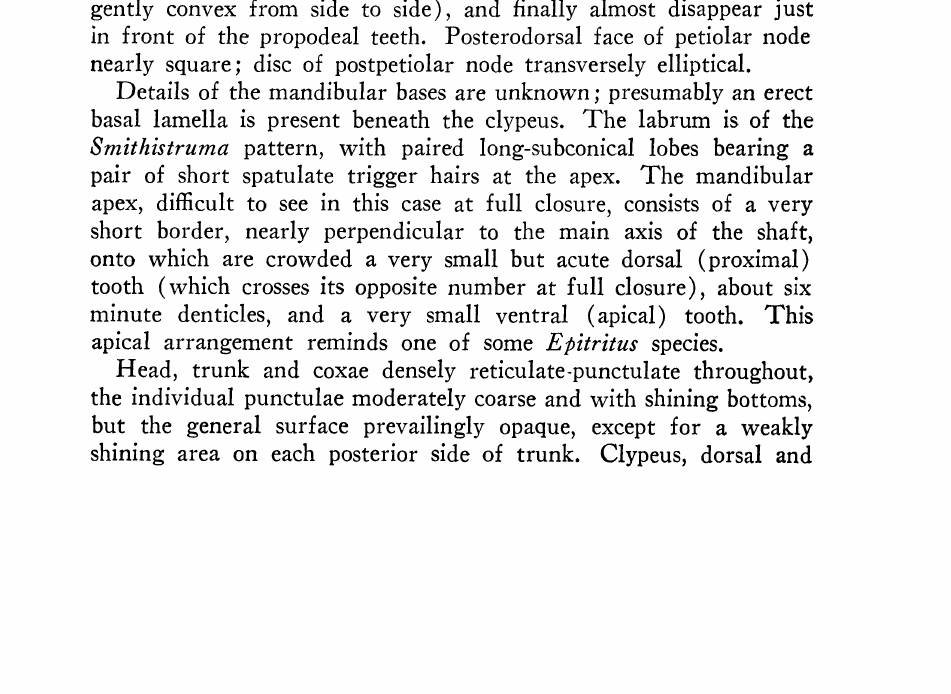
Fig. 2. dskelogenys acubecca new species, holotype worker, full-face (dorsal) view of head, only fringing pilosity shown for upper part. Drawn by Bente